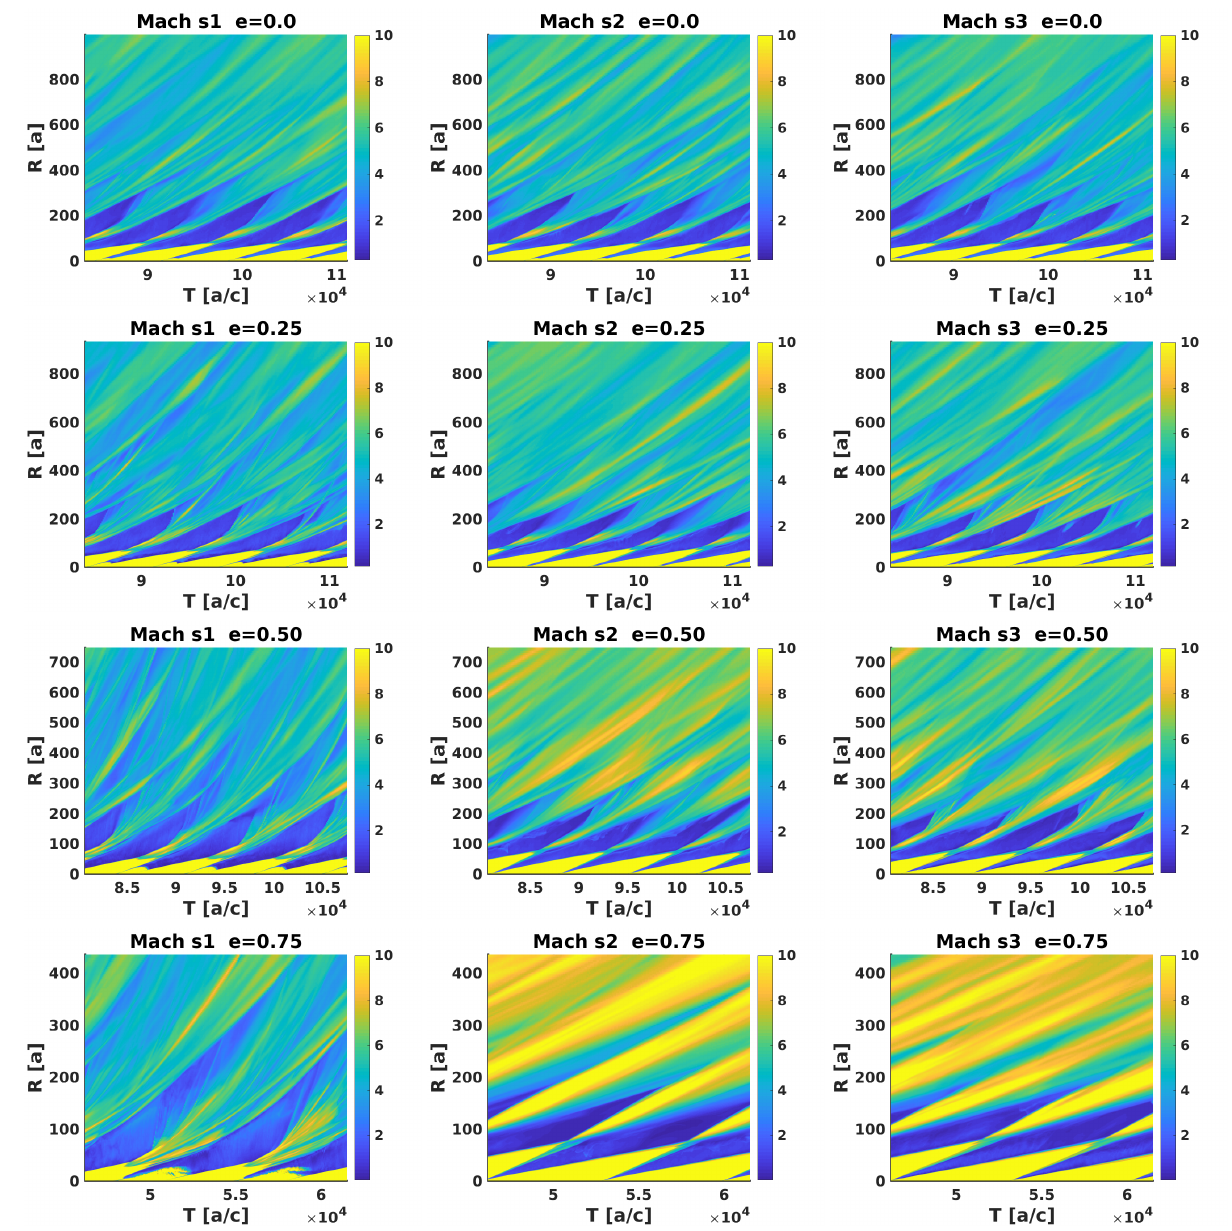
Figure 8. The same as in Figure 7 but for Mach